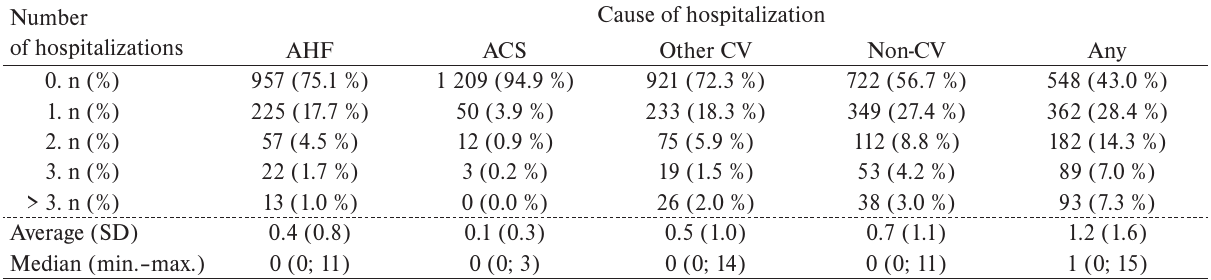
Table 2. Number of hospitalizations during the first two years following discharge from index hospitalization (n = 1274).